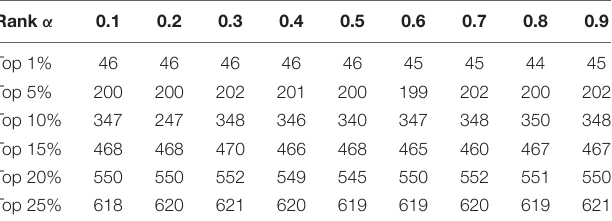
TABLE 2 | Influence of the parameter α on prediction accuracy of KTCSPM based on the DIP